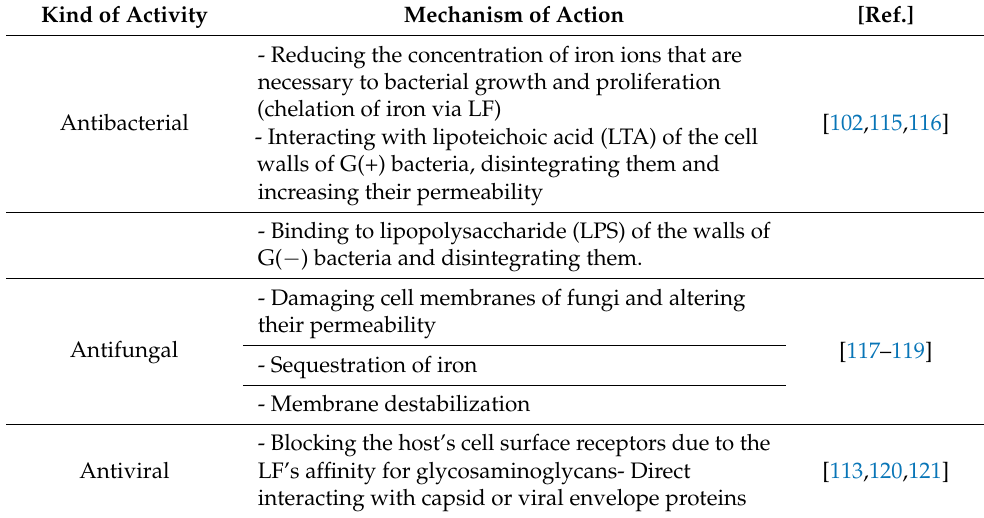
Table 3. Mechanisms of lactoferrin